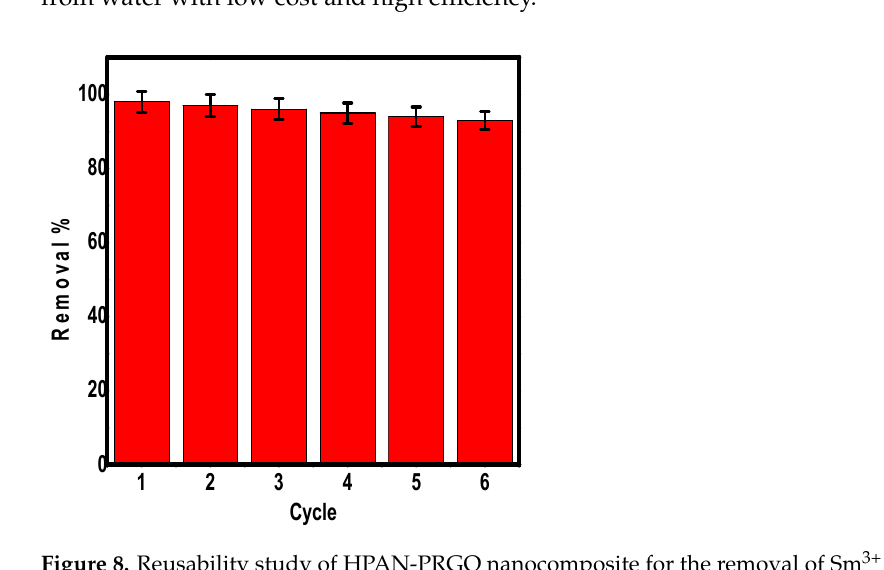
Figure 8. Reusability study of HPAN-PRGO nanocomposite for the removal of Sm 3+ ions up to six successive cycles.